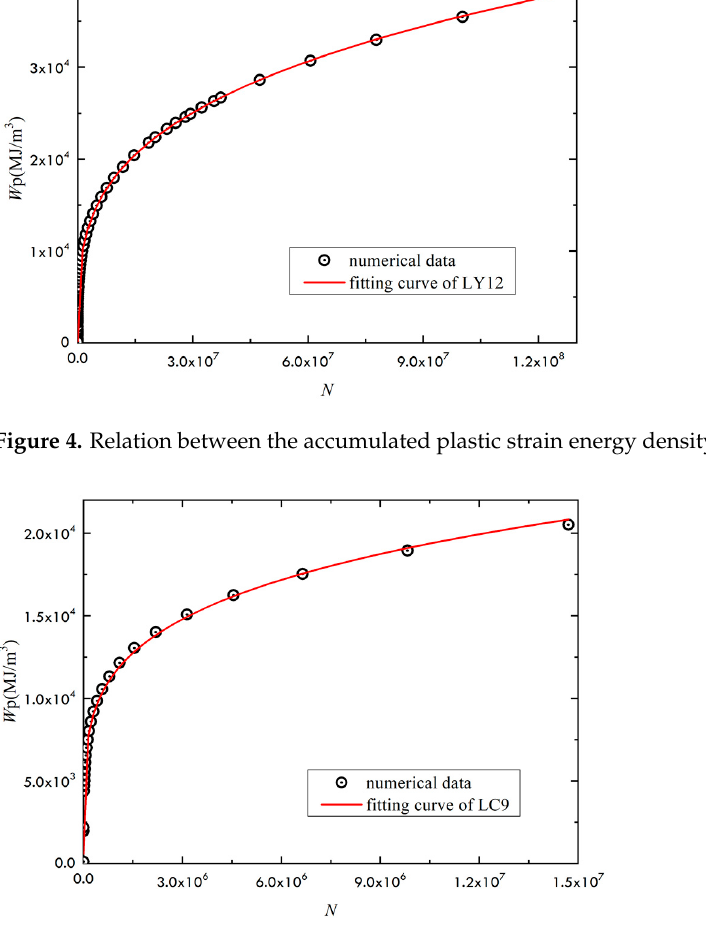
100 Table 7. Life estimation of LC9. ε pa (%) σ a (MPa) Δ W p (MJ/m 3 ) Fatigue Crack Ini- tiation life